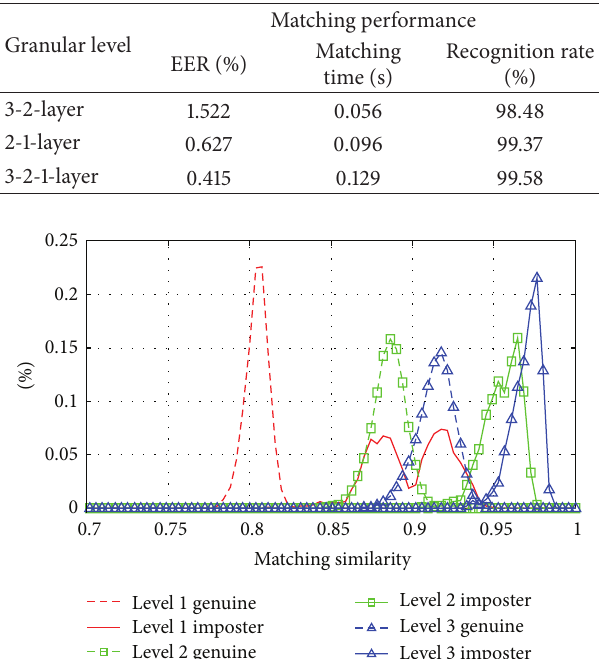
Table 2: Matching results of the top-down matching method.